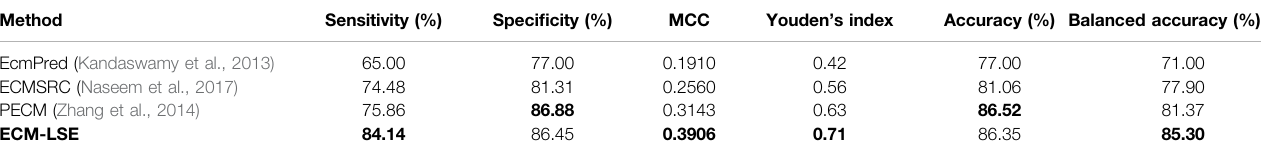
Bold-face represent best